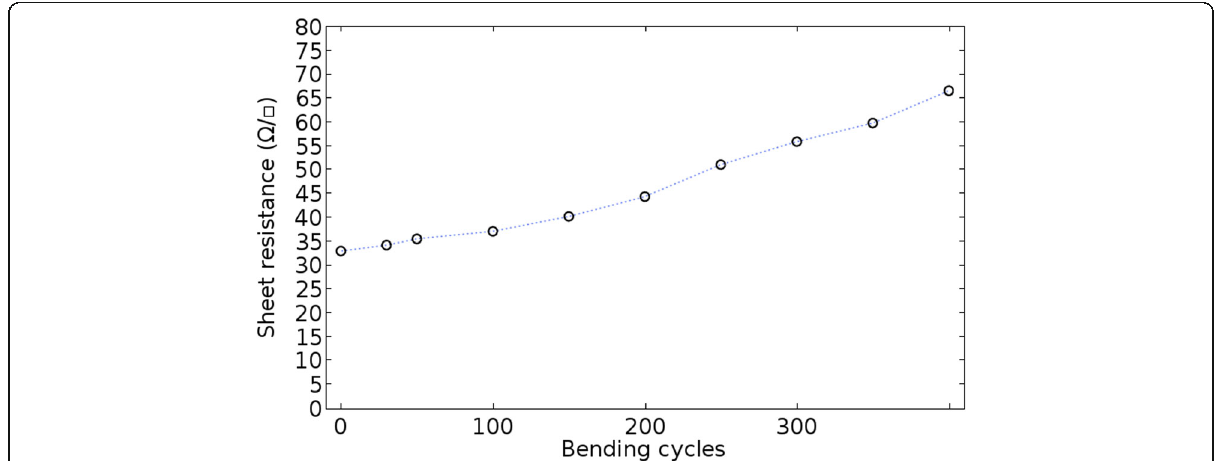
Fig. 6 The sheet resistance vs. bending cycles in the mechanical bending test of AuNM (at W5 = 160 nm and thickness = 20